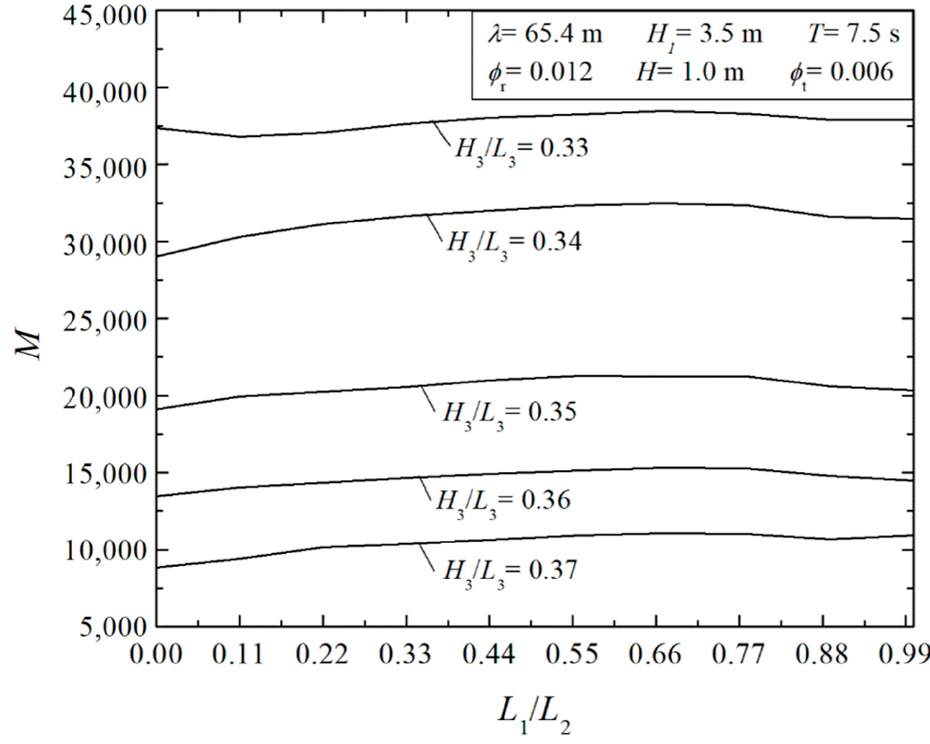
Figure 8. Influence of ratio L 1 / L 2 over the mass of water considering different H 3 / L 3